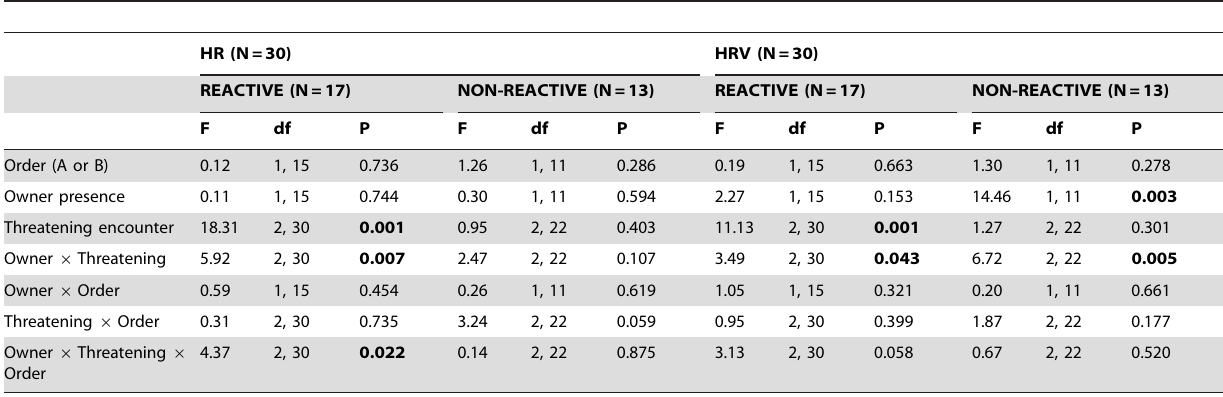
Table 3. Results regarding the change of the cardiac responses of dogs depending on their behavioural reactivity during the threatening approach (repeated measures ANOVA).